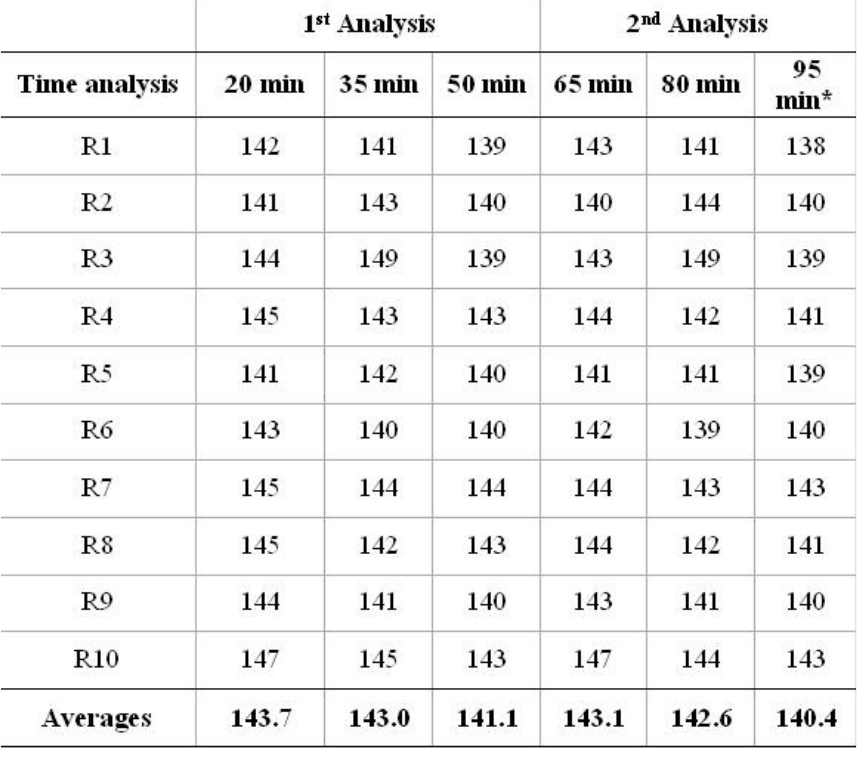
TABLE 1 – Na + values in the first and second gasometrical analysis during the blood storage on